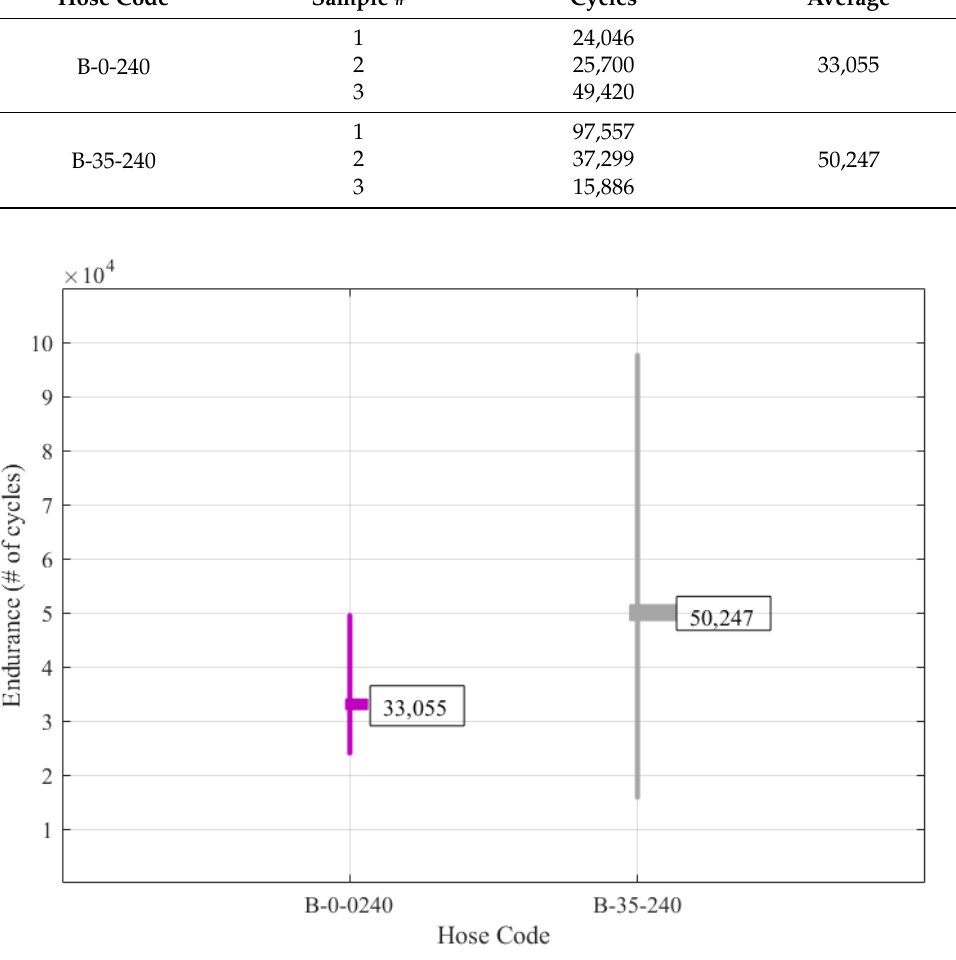
Figure 10. Influence of the printing angle in the hose endurance: average, minimum, and maximum number of cycles.